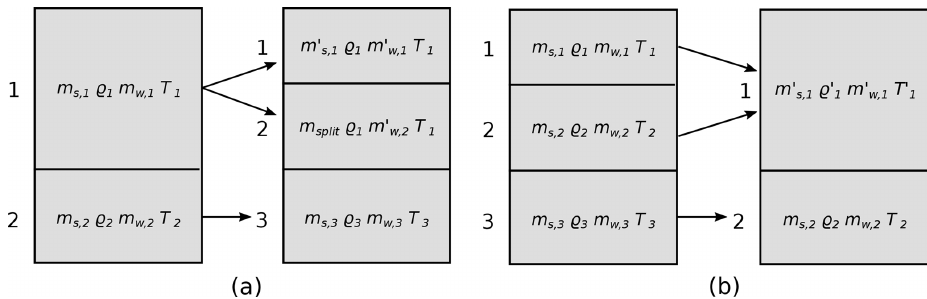
Figure 2. (a) Splitting of a box that exceeds the maximum snow mass m max . (b) Merging of two boxes in case the mass of the uppermost box falls below m min . Table 2. Table of physical constants and model constants. The tuning parameters have their tested values listed in brackets. Quantity